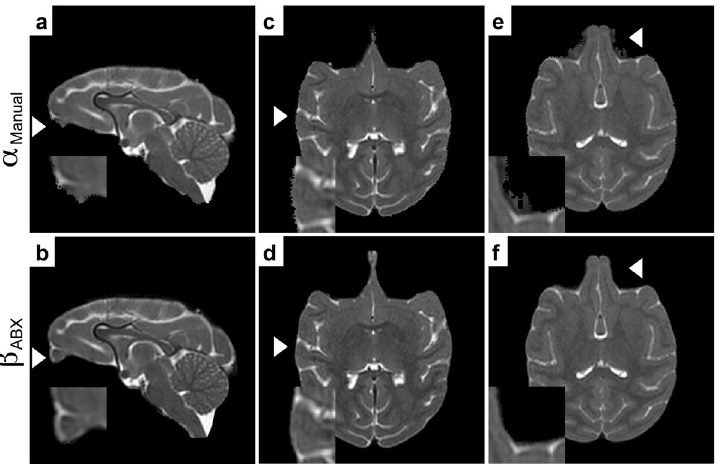
Figure 4. Comparison between atlasBREX (ABX) and manual delineation from UNC-Wisconsin Rhesus Macaque Neurodevelopment Database. Representative cases from juvenile rhesus macaque (n = 8, T2) presenting common disadvantages of manual (hybrid) brain extraction ( α ), which is operator-dependent and time-consuming, compared to (semi-) automated skull-stripping ( β ) using ABX. First two panels ( a , b ) show common erosion of the olfactory bulb. Jagged edges with marginal erosion of brain tissue are depicted in the following two panels ( c , d ). Last panels ( e , f ) demonstrate inaccurate delineation. White arrow indicates the magnified